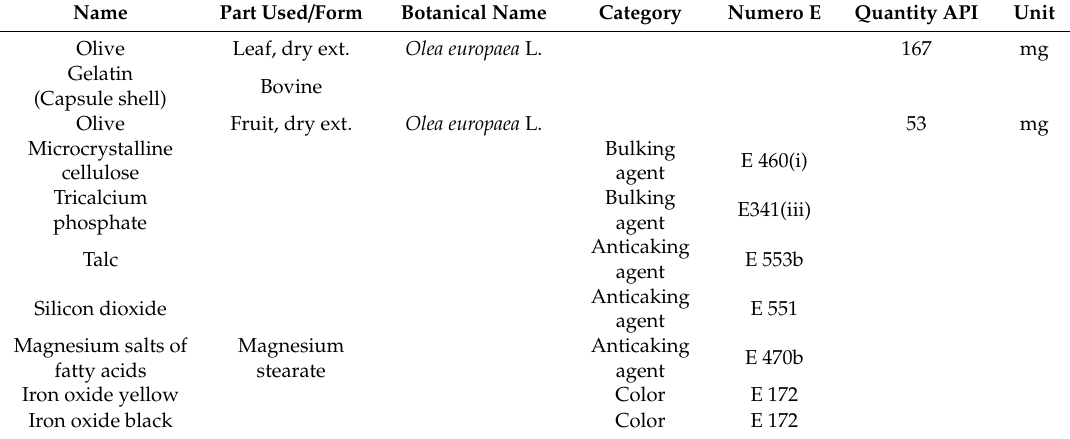
Table 1. Composition per capsule of Tensiofytol in decreasing order according to Regulation (EU) No 1169 / 2011 Article 18 and Annex VII.